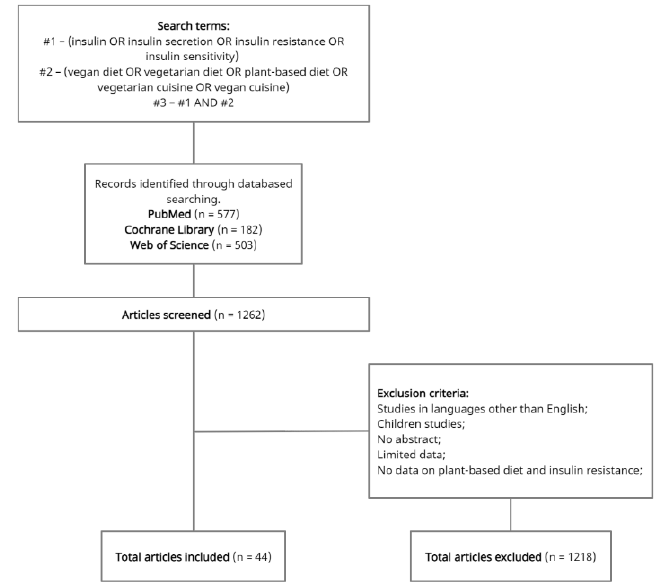
Figure 1. Full search strategy.